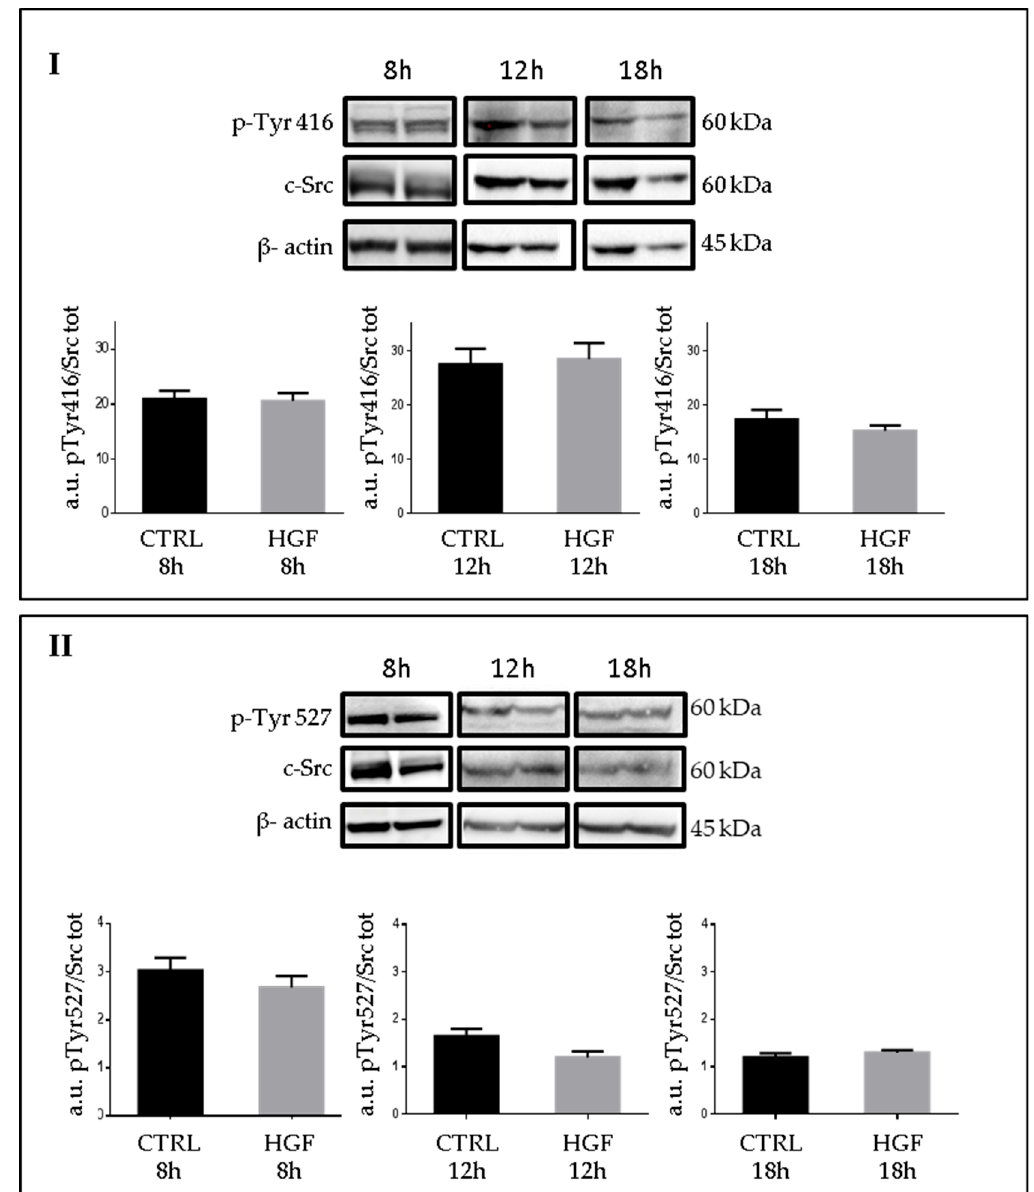
Figure 7. c-Src expression and phosphorylation of NT2D1 cells exposed to HGF: (I) Western blot analyses of c-Src Phospho Tyr 416, total c-Src protein, and β - actin in NT2D1 cell lines cultured for 8 h, 12 h and 18 h with or without HGF. In the lower part of the panel the densitometric analyses of c-Src phospho Tyr 416 bands normalized versus total c-Src/ β -actin are shown. (II) Western blot analysis of c-Src phospho Tyr 527, total c-Src protein, and β - actin in NT2D1 cell lines cultured for 8 h, 12 h and 18 h with or without HGF. In the lower part of the panel the densitometric analyses of c-Src phospho Tyr 527 bands normalized versus total c-Src/ β -actin are shown.